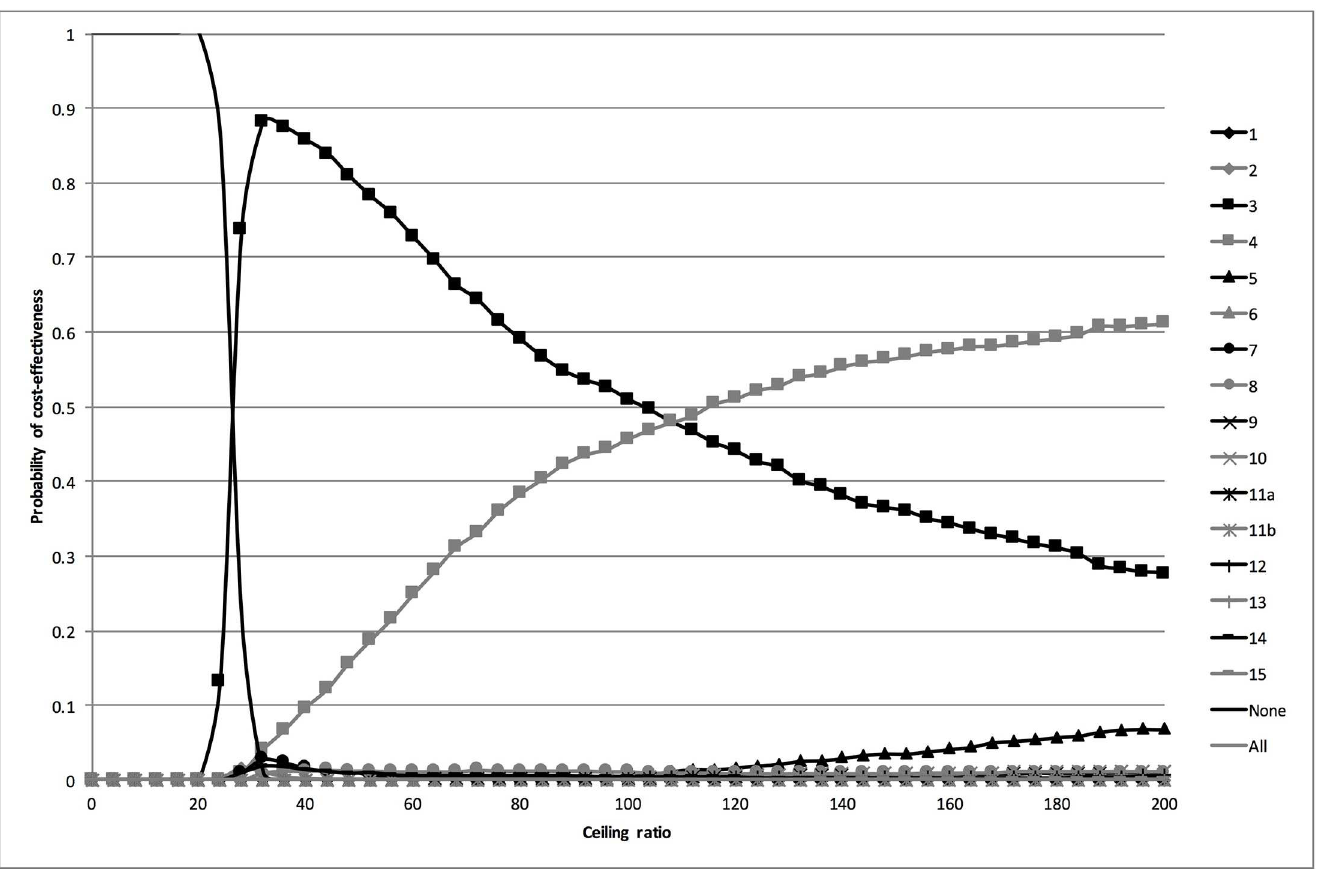
Fig 6. Cost-effectivenessacceptability curves for the analysis including treat-none and treat-all strategies. The cost-effectiveness acceptability curves are basedon the probabilisticanalysis. They show the probabilitythat the different diagnosticstrategies are cost-effective at a range of ceiling